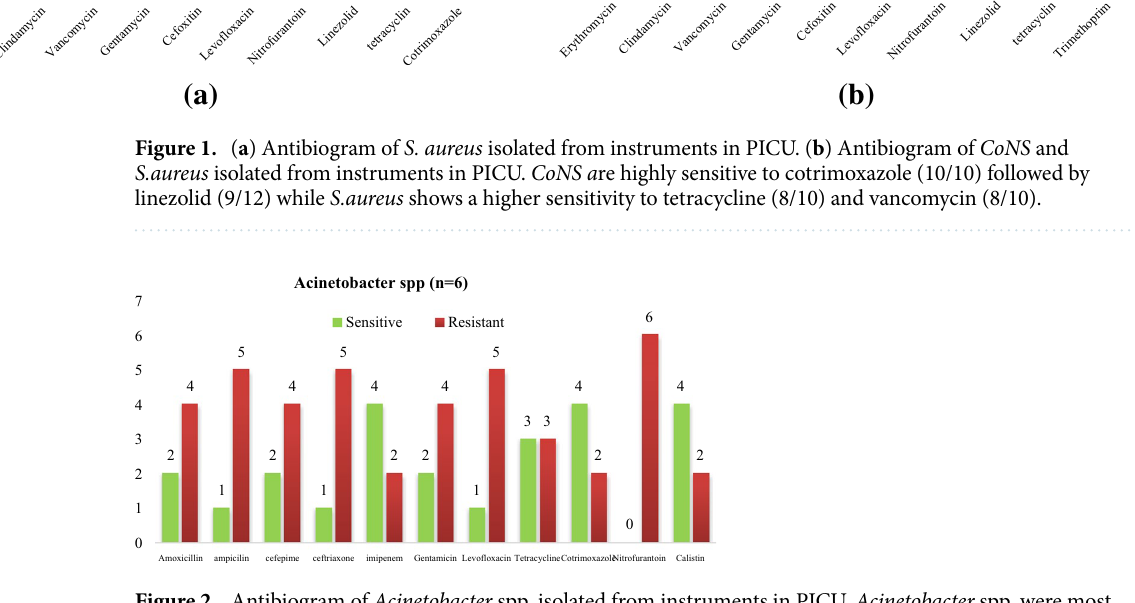
Figure 2. Antibiogram of Acinetobacter spp. isolated from instruments in PICU. Acinetobacter spp. were most sensitive to (4/6) colistin (4/6) followed by imipenem (4/6).